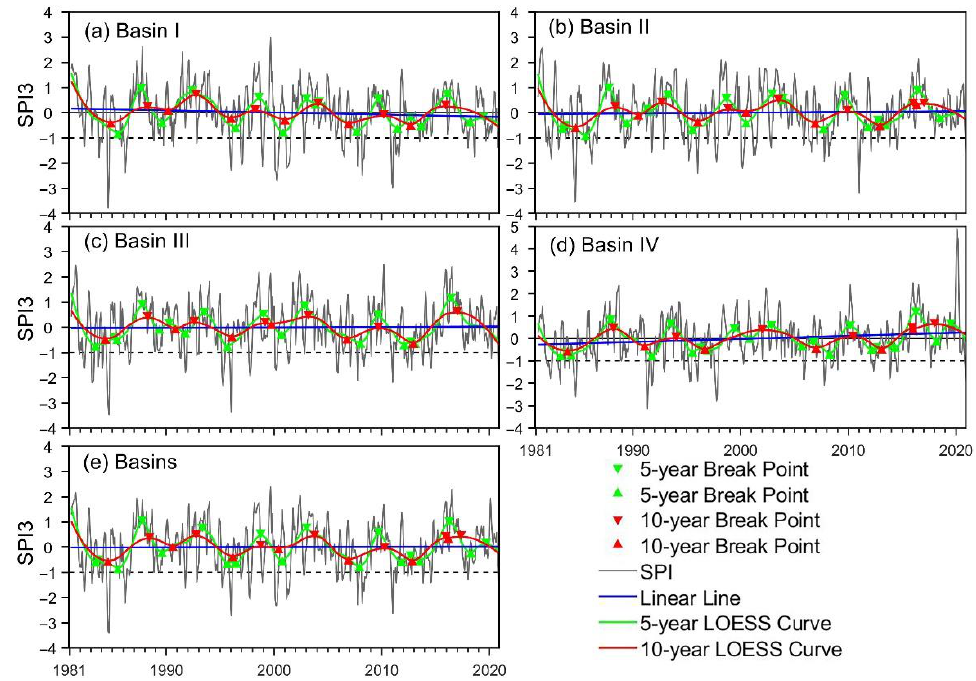
Figure 8. Temporal evolution of domain-averaged SPI3 in the study area and each basin ( a – e ). In this study, Sen slope and MMK significance tests were performed based on the domain-averaged SPI3, so as to further quantitatively analyze the drought trend from 1981 to 2020.